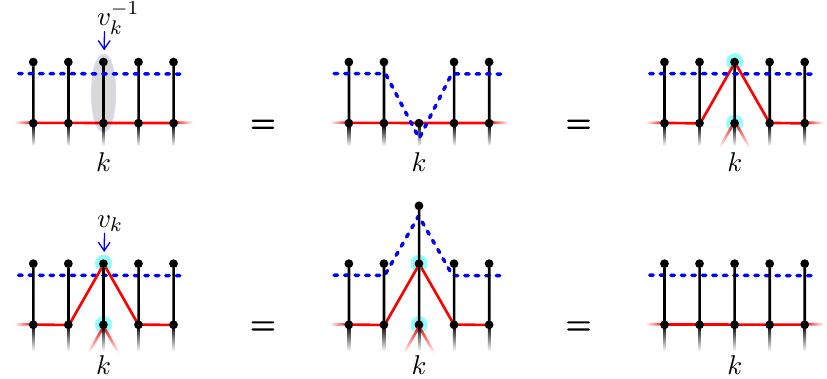
and v k on a CFT wave k